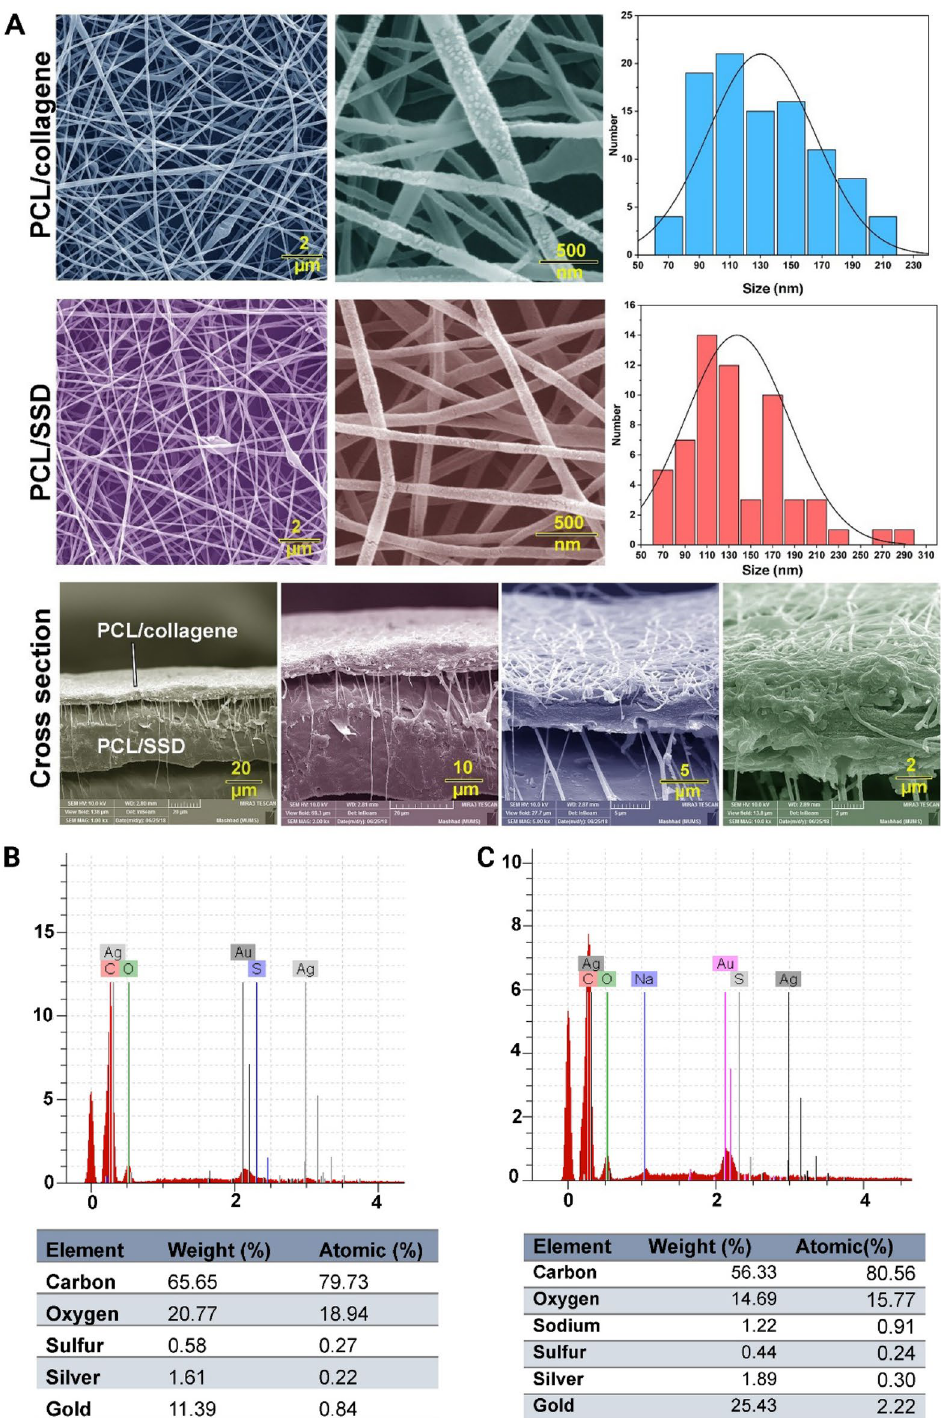
Figure 2. Morphological characteristics of the double-layered nanofibrous mat with FE-SEM. ( A ) the top layer is PCL/Coll and the bottom layer is PCL/SSD, which are shown with size distribution. The placement of the double-layered nanofibrous mat is shown in the bottom-most panel. The presence of nanofiber filaments in the cross-section between the two layers indicates that the two layers are connected to each other. Elemental analysis was done on the double-layered nanofibrous mat without GSE ( B ) and the double-layered nanofibrous mat with GSE ( C